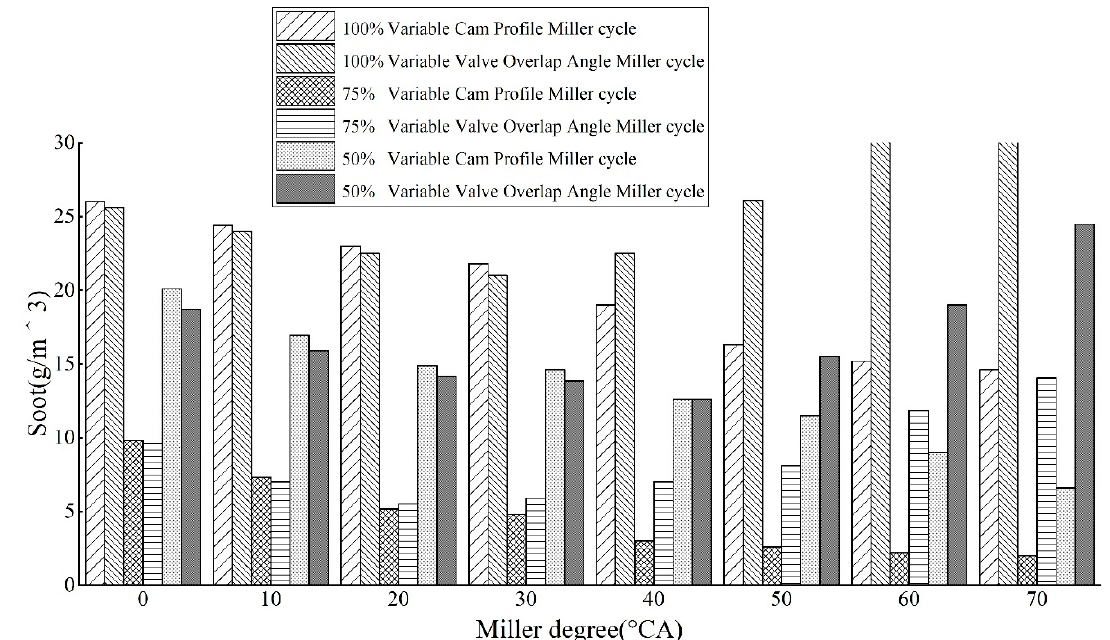
Figure 7. Soot emission analysis under three working conditions.